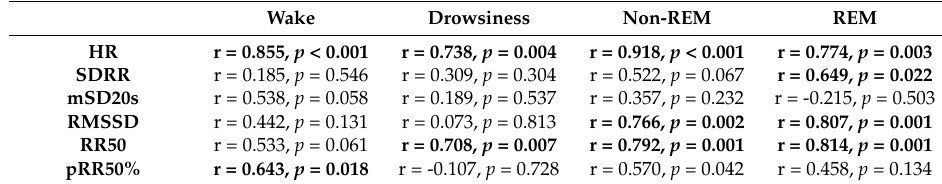
Table 6. Differences between ECG parameters following positive versus negative social interactions (5-min sampling from the first occurrence of a given sleep stage). Significant differences are highlighted with bold